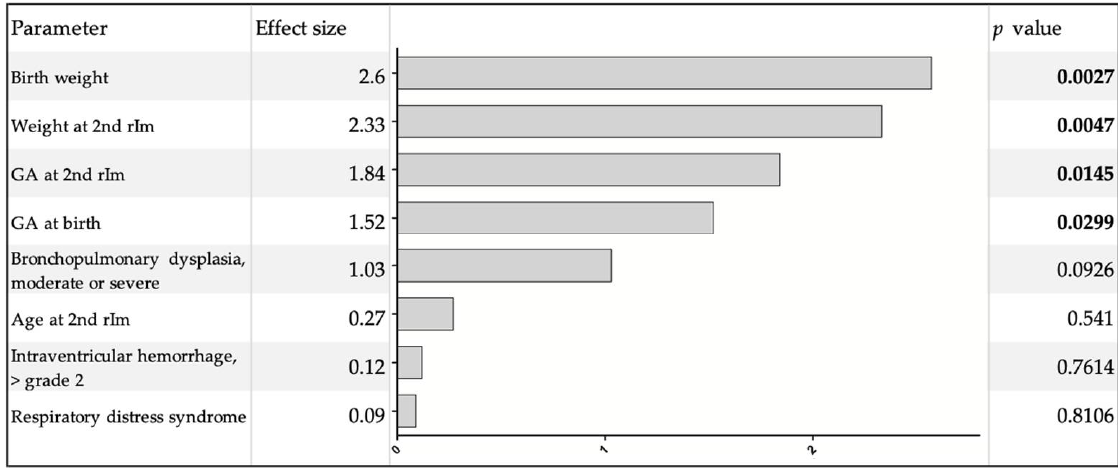
Figure 2. Multivariate regression analysis of possible risk factors for CRE-ts. Significant values are shown in